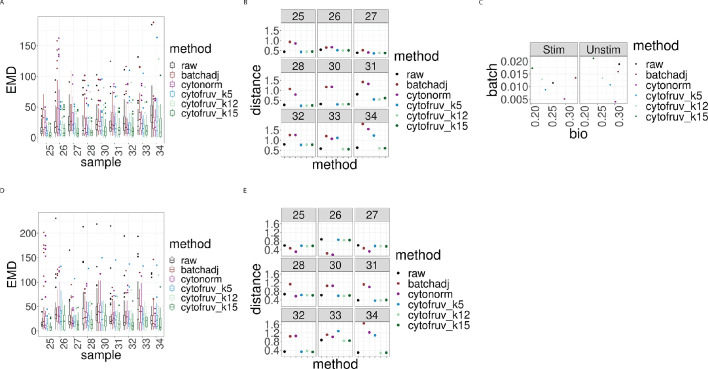
Metrics to assess the effectiveness of the normalisation methods on samples two from the CytoNorm dataset using both the stimulated and unstimulated samples one as replicated reference samples.In all panels, the colour indicates either the raw data or the method used for normalisation. (A) Boxplots of the Earth Movers Distance (EMD) between paired protein expression distributions for each batch’s stimulated sample across compared to that in the first batch. (B) Hellinger distances between paired cell subpopulation proportions for each batch’s stimulated sample compared to that in the first batch. (C) Mean Silhouette scores computed for all stimulated and unstimulated samples with those for cell subpopulations (bio) on the x-axis and for batch (batch) on the y-axis. (D) Same as (A) for the unstimulated samples. (E) Same as (B) for the unstimulated samples.